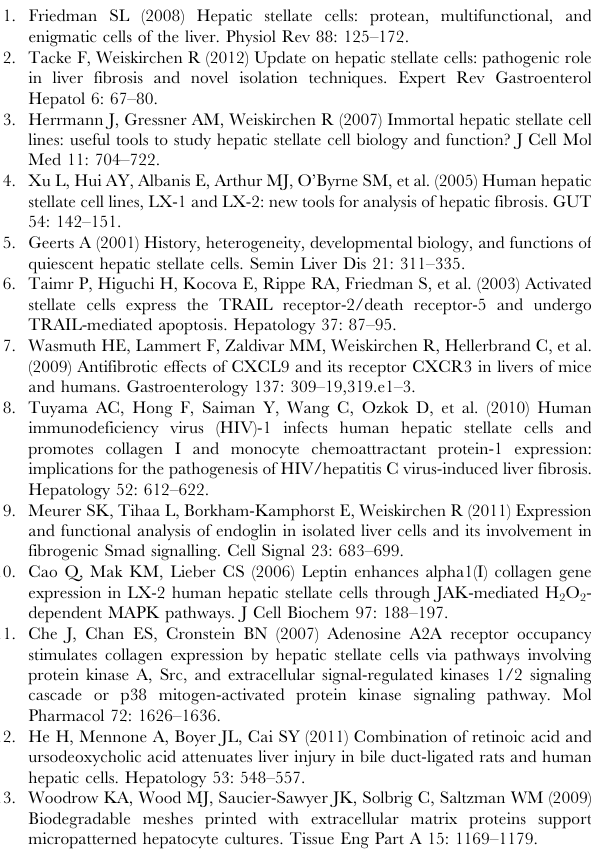
Table S2 Spectral karyotyping (SKY) analysis of LX-2 cells. Table S3 Short tandem repeat analysis of cells used in this